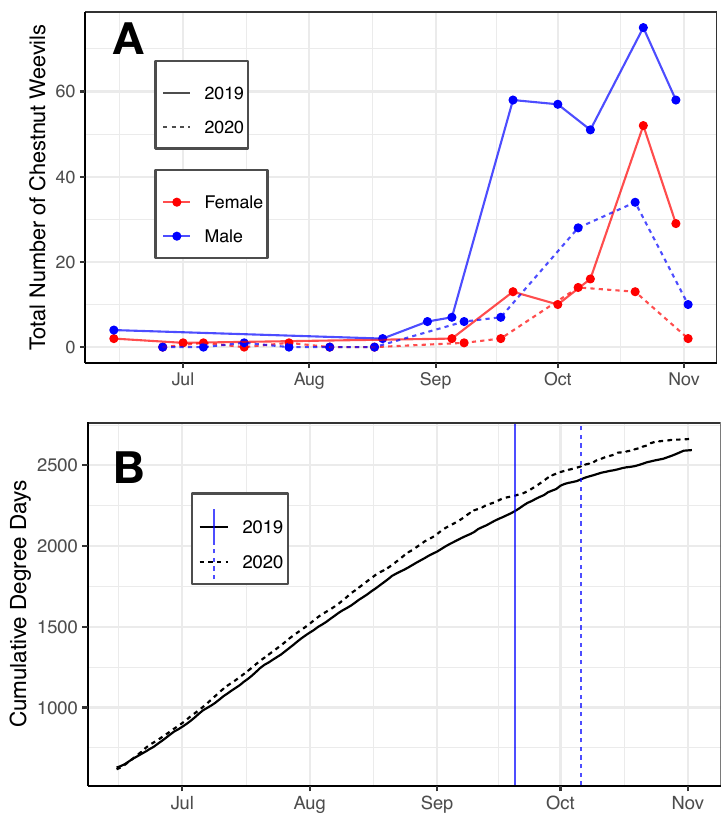
Figure 1. Phenology of the lesser chestnut weevil ( C. sayi ). ( A ) C. sayi male and female trap catch in 2019 and 2020. Data are summed across traps and trap types. ( B ) Degree day accumulations for 2019 and 2020. Degree days were calculated with a base of 4 ◦ C using the Baskerville–Emin method beginning 1 April. Blue vertical lines denote first day in the season when more than 10 adult C. sayi individuals were